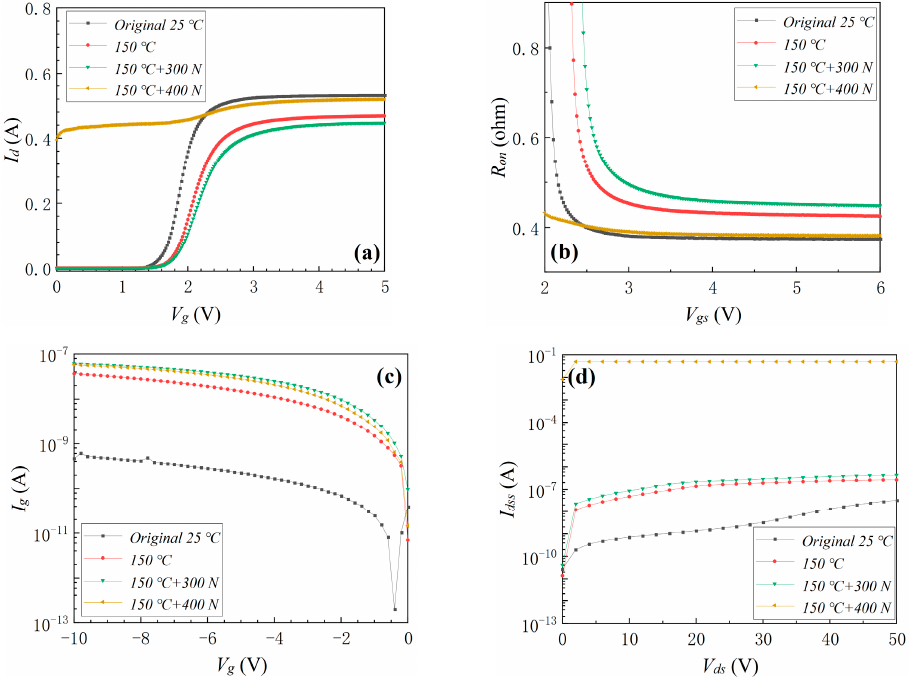
Figure 9. The device’s transfer characteristic ( a ), R on ( b ), I g ( c ) and I dss ( d ) before and after thermo-mechanical coupling stress.